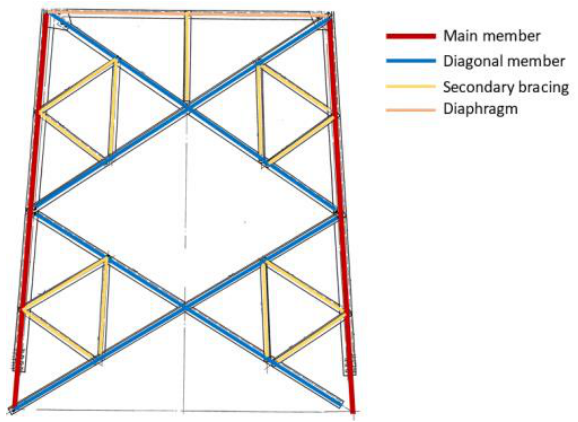
members provide the main members with constraints. There are two types of auxiliary tower by offering redundant constraints.